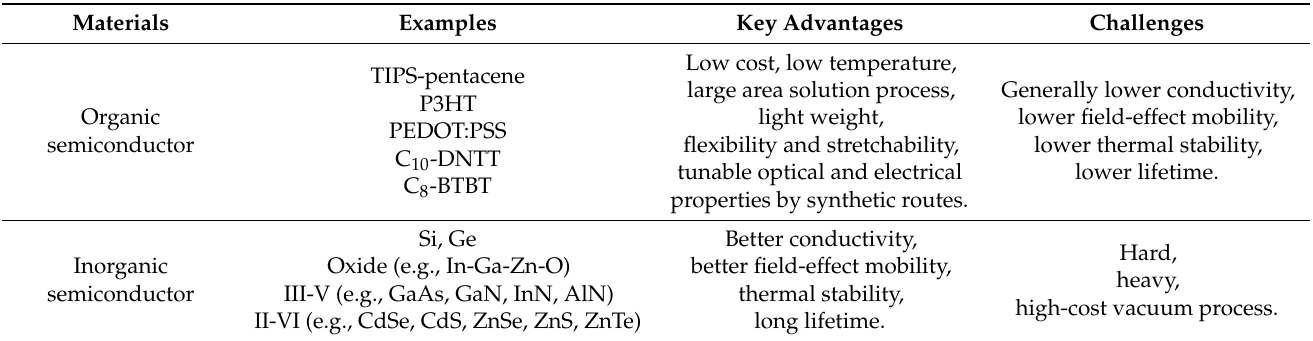
Table 1. A comparison table of key advantages and challenges for representative organic semicon- ductors and inorganic